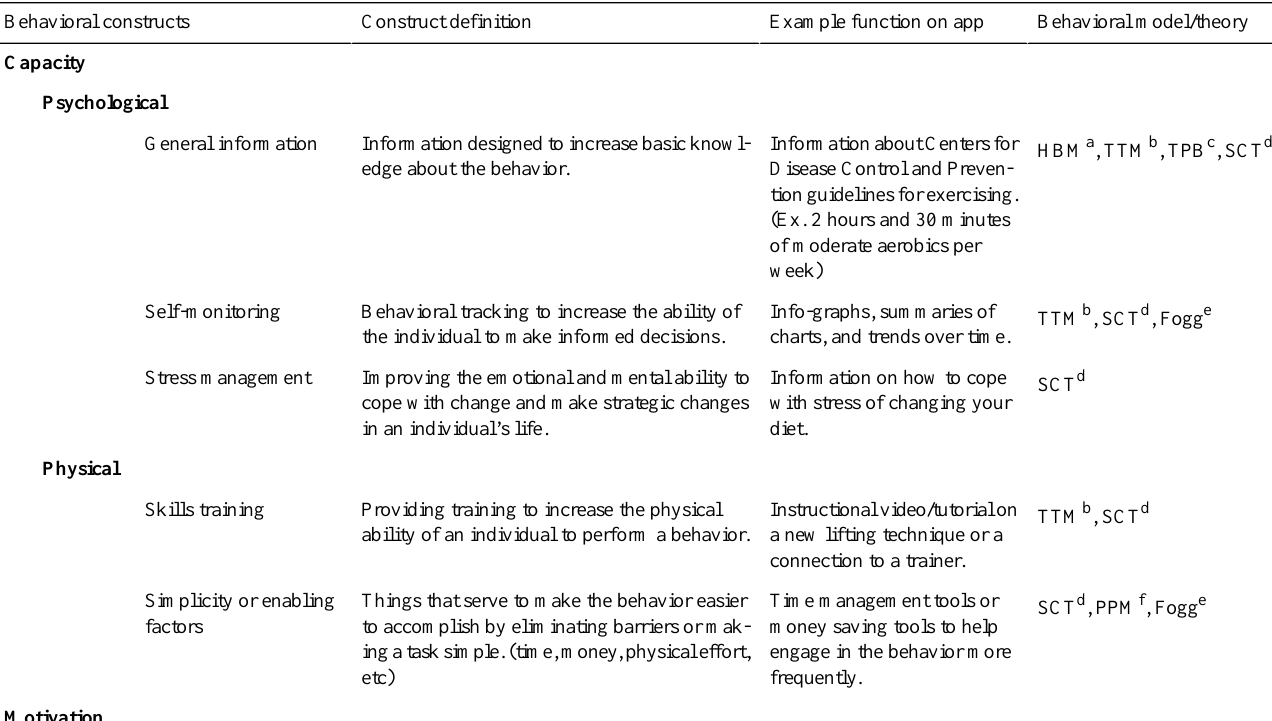
Table 2. Construct definitions and app